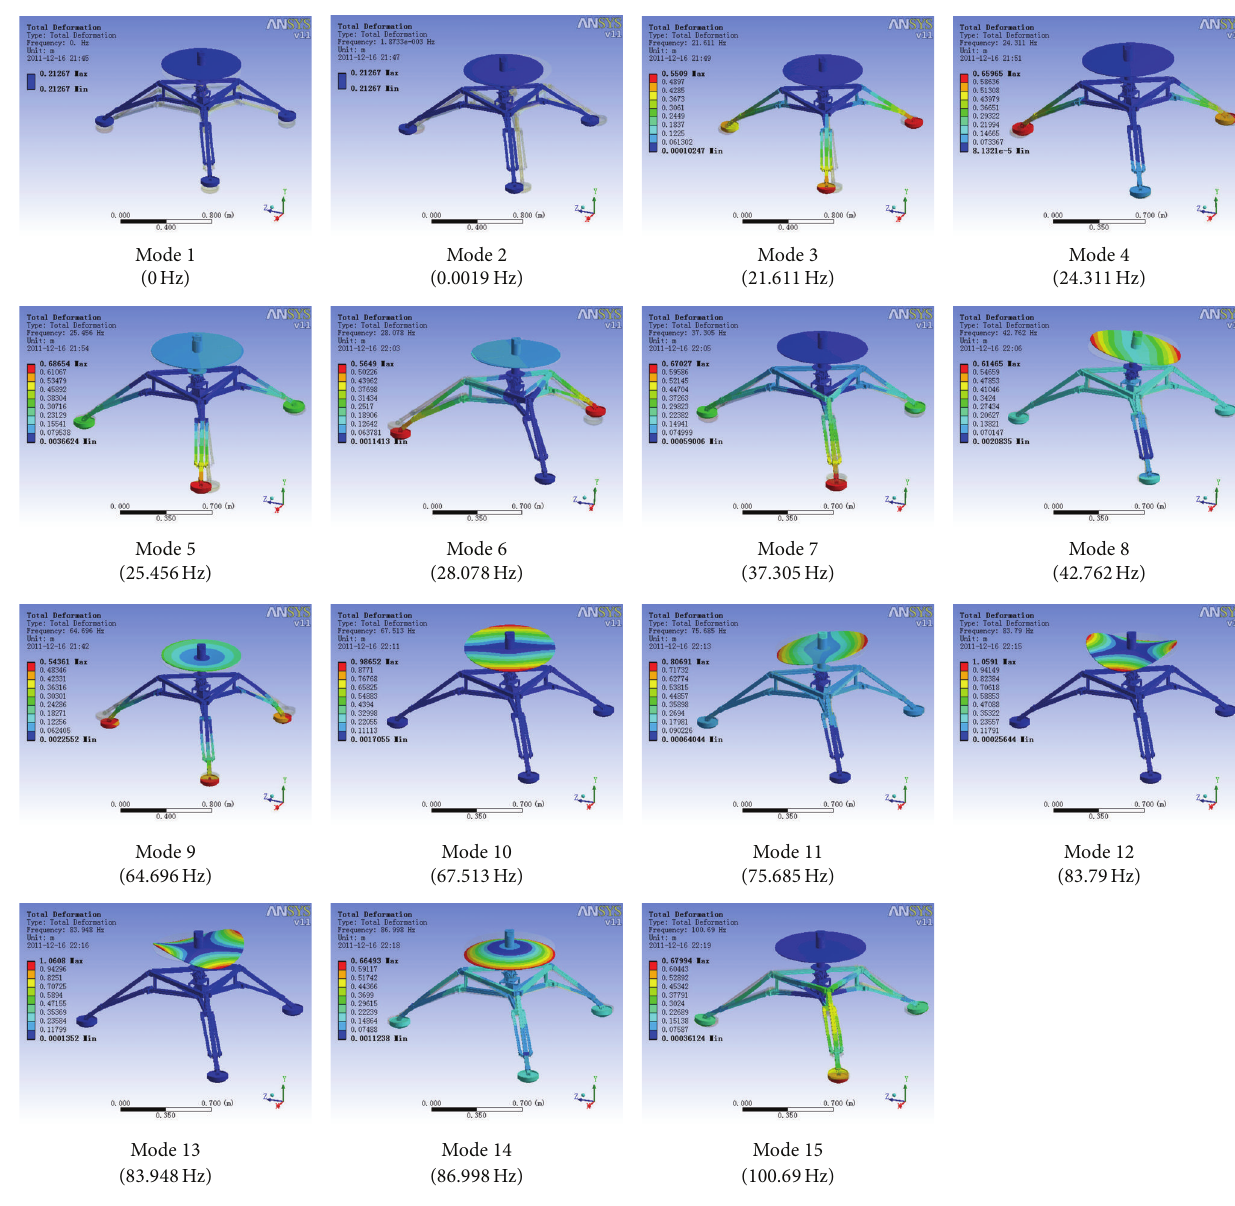
Figure 4: Modal analysis of the deployed landing